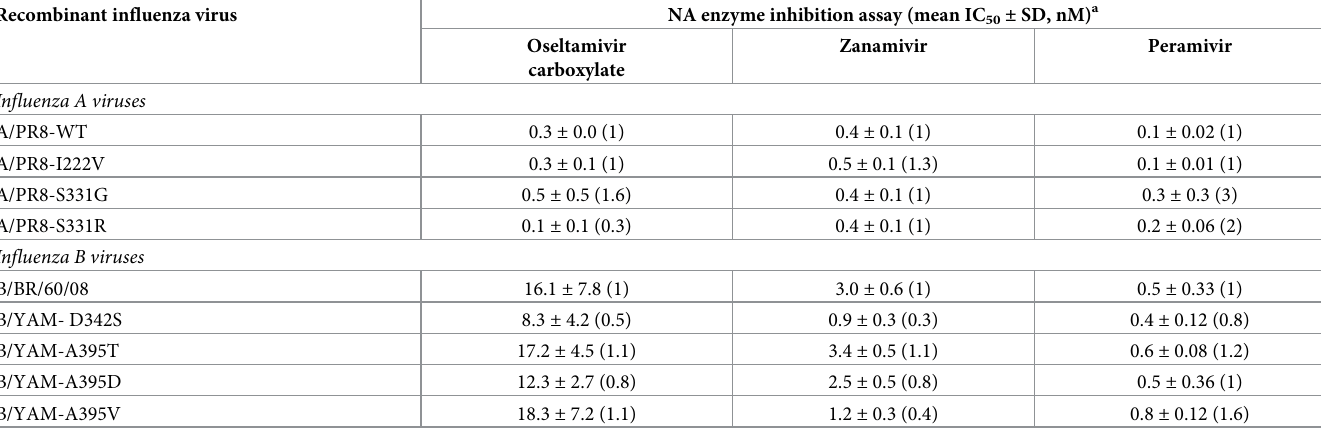
Table 2. NAI susceptibility profiles for recombinant influenza A and B viruses carrying a single NA substitution.